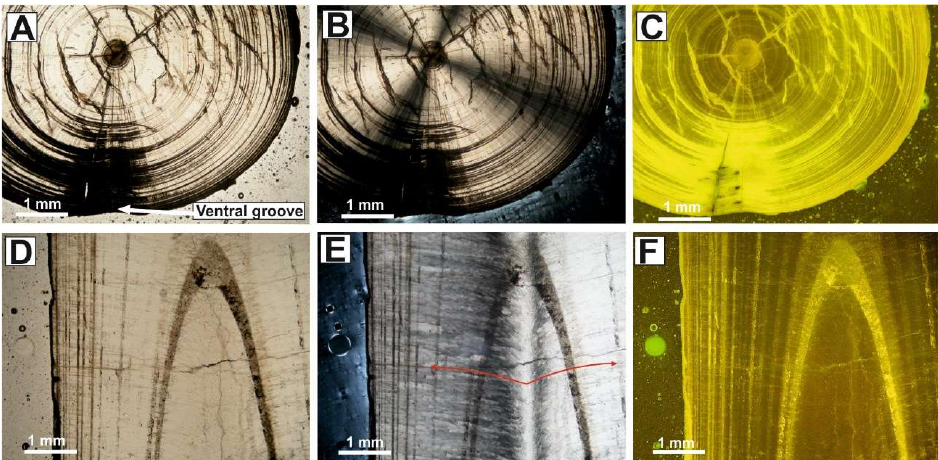
Figure 5. Transversal ( A – C ) and longitudinal ( D – F ) thin sections of the same belemnite rostrum (specimen PC-39) observed under TL ( A , D ), PL ( B , E ), and FL ( C , F ) microscopy. Note the concentric growth layering, enhanced under FL, and the undulose extinction, under PL. Red arrows observed in ( E ) indicate the sense of crystal growing from the apical line.